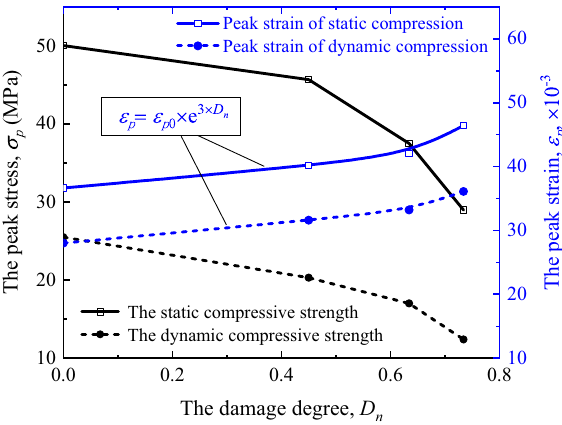
Figure 8. Influence law of damage degree of filled rock joints specimens on compression characteristics.